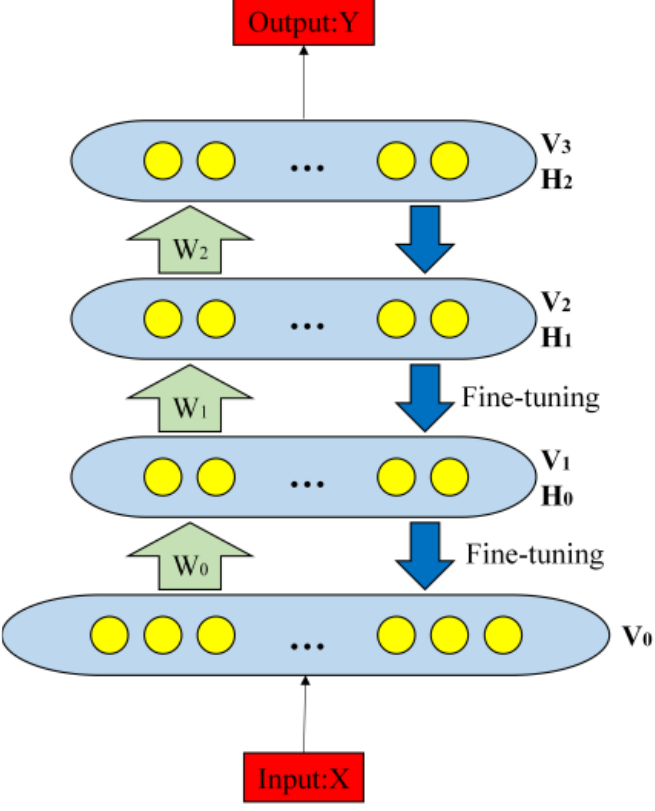
Figure 6. Frame structure of the DBN.